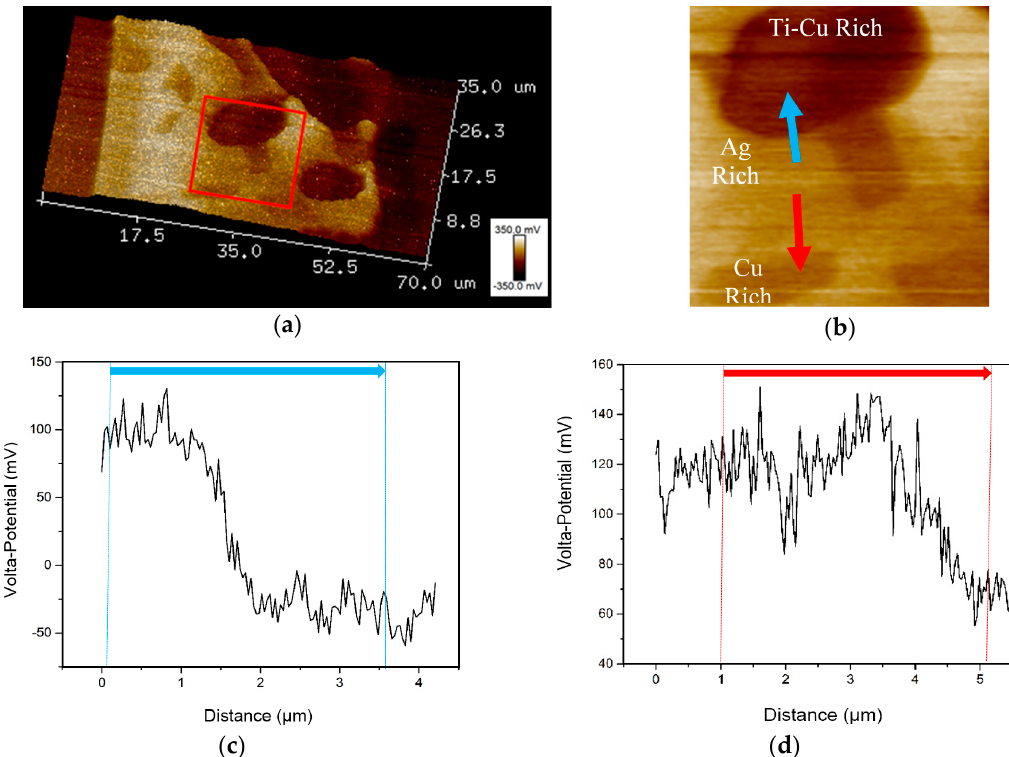
Graph of potential values obtained from scan as a function of distance with indicating arrow.